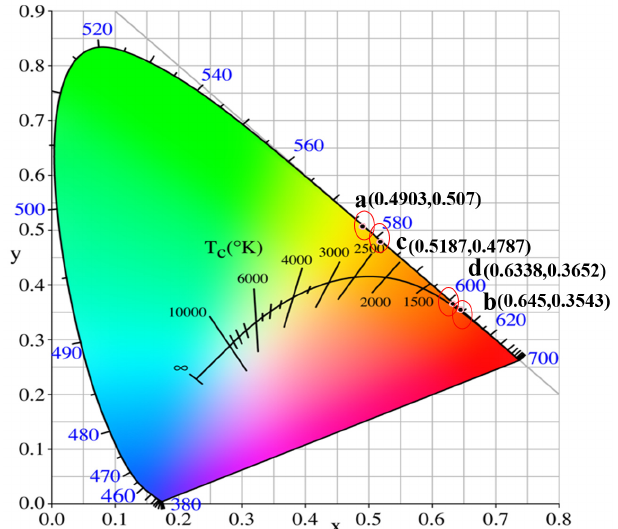
Figure 8. CIE chromaticity coordinates for the ( a ) as-grown Eu:GAP crystal; ( b ) annealed Eu:GAP crystal; ( c ) as-grown Eu:GLAP crystal; ( d ) annealed Eu:GLAP crystal. The XEL spectra of the Eu:GAP and Eu:GLAP crystals with or without the 1000 °C for 4 h in Ar + 5% H 2 annealing process are shown in Figure 9, with a Bi 4 Ge 3 O 12 (BGO) single crystal as a reference sample. The typical 5D 0 → 7F J transition of Eu 3+ under X-ray excitation was almost the same as that of the PL ( λ ex = 275 nm) spectra. The significantly increased strength of the annealed crystals is expected to make them a potential candidate for applications in X-ray detection and imaging.